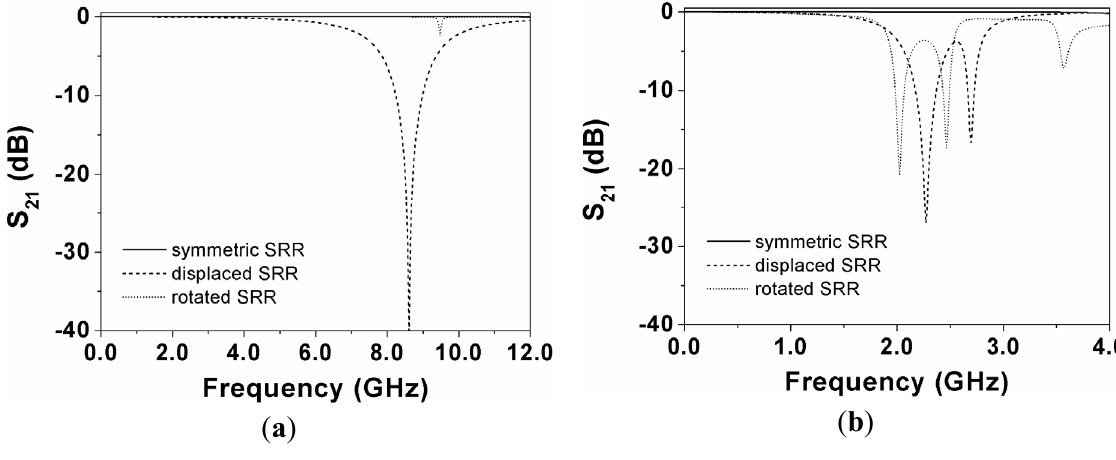
Figure 4. ( a ) CPW loaded with a square shaped SRR; and ( b ) CPW loaded with a rectangular shaped SRR. Dimensions are: L